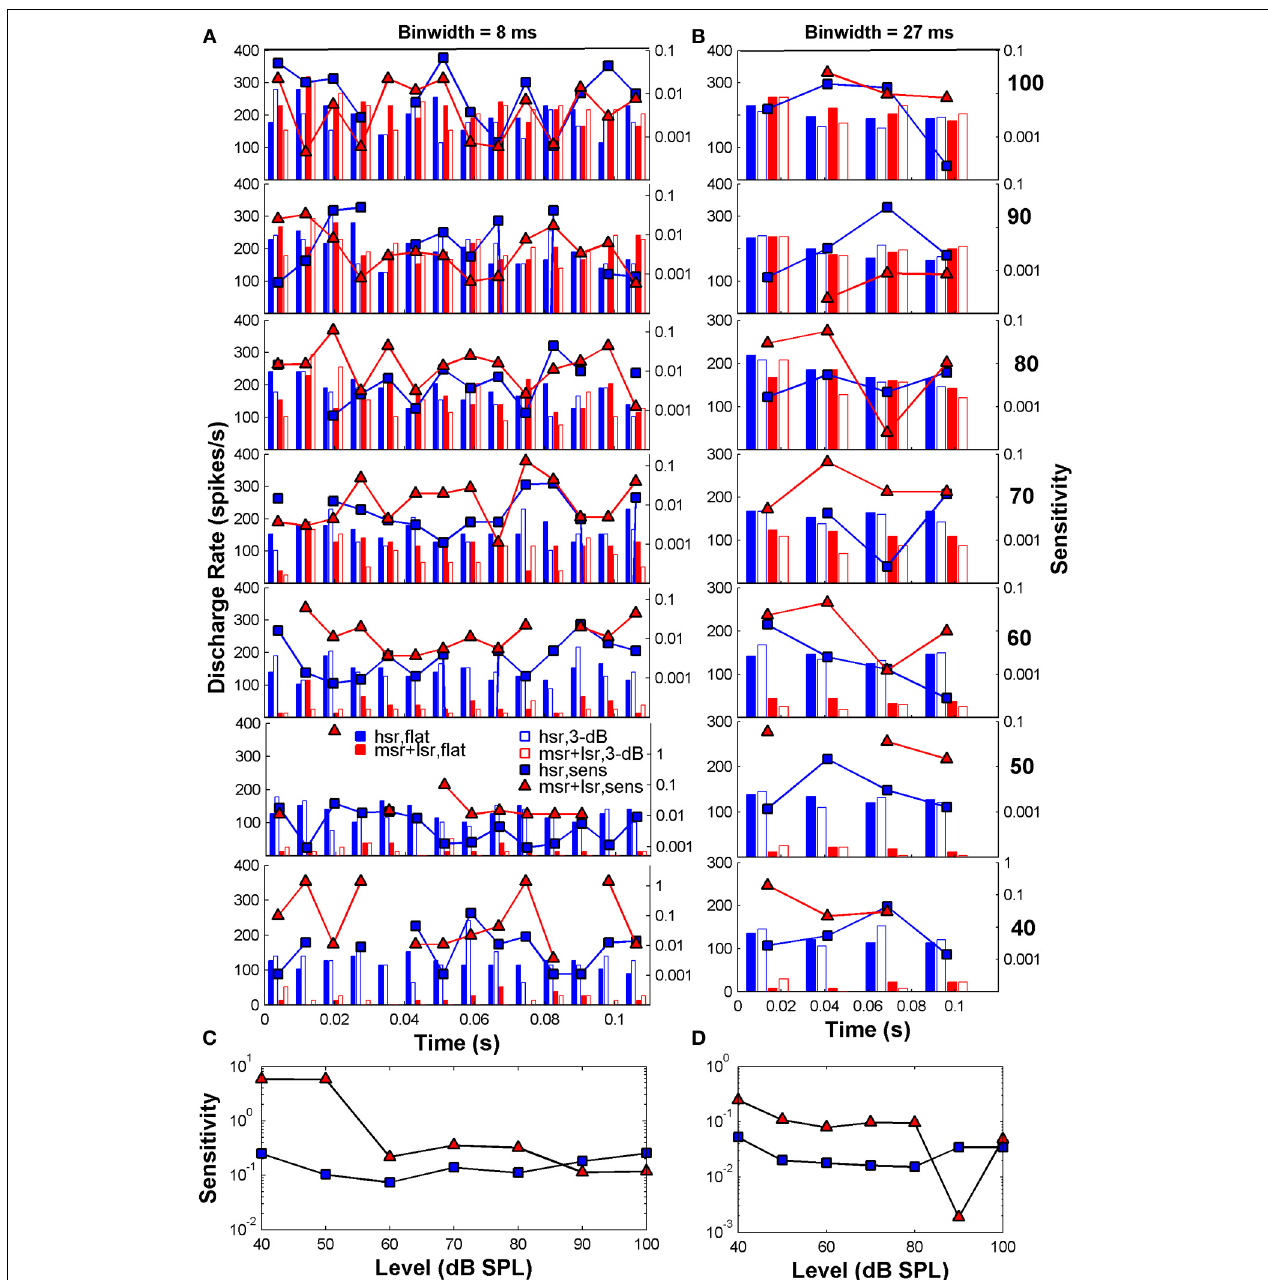
FIGURE 3 | Auditory nerve data: example post-stimulus time histograms (PSTHs; scale on the left y-axis) and related sensitivity (scale on the right y-axis) for one HSR fiber (blue bars and squares: CF = 3.6Hz, SR = 111 spikes/s, 10 repeats/stimulus) and one LSR fiber (red bars and triangles: CF = 6.9Hz, SR = 11.2 spikes/s, 10 repeats/stimulus). (A) PSTHs calculated for time binwidths of 8ms. (B) PSTHs calculated for a binwidth of 27ms. In each panel, filled and open blue bars illustrate the PSTHs for the HSR fiber when stimulated with a flat-spectrum and 3-dB-deep notch noise, respectively. Filled and open red bars illustrate corresponding PSTHs for the LSR fiber. Each row illustrates results for a different stimulus level as indicated by the bold numbers on the right part of the figure (in dB SPL). Also represented in each panel is the fiber’s sensitivity in each time bin (log-scale on the right y-axis) for each of the two fibers (blue squares for the HSR fiber; red triangles for the LSR fiber; one symbol per bin). Sensitivity was calculated using Equation (2b) and